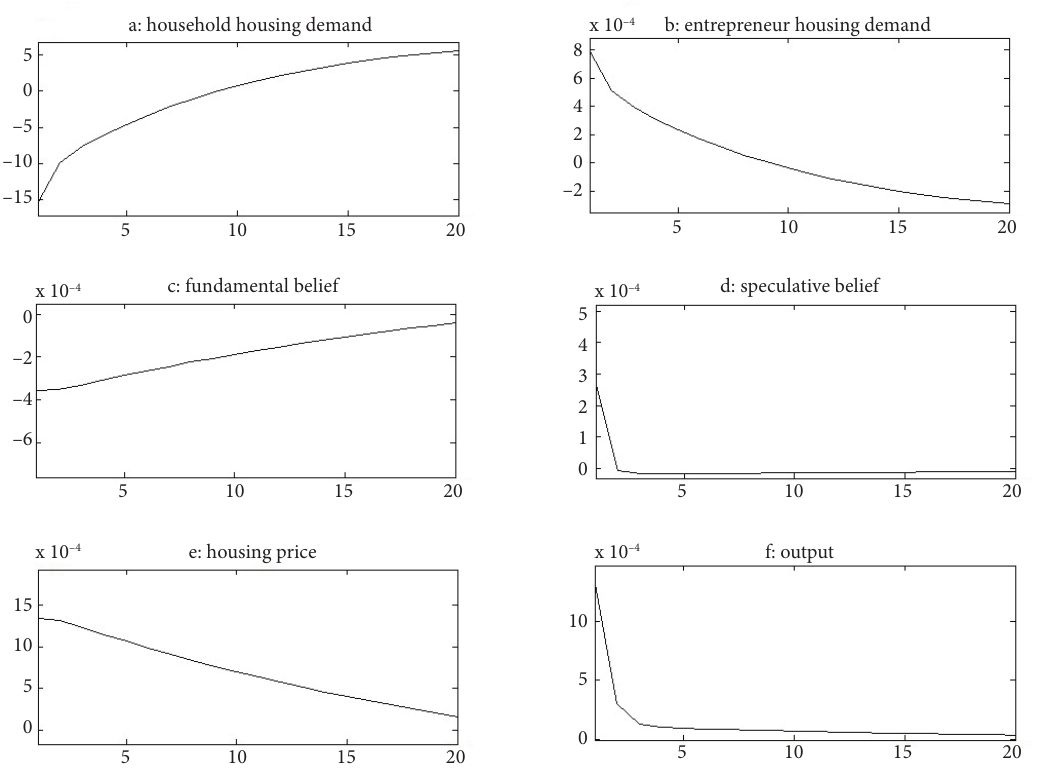
Figure 2. Impulse responses to an (one standard deviation) positive down payment